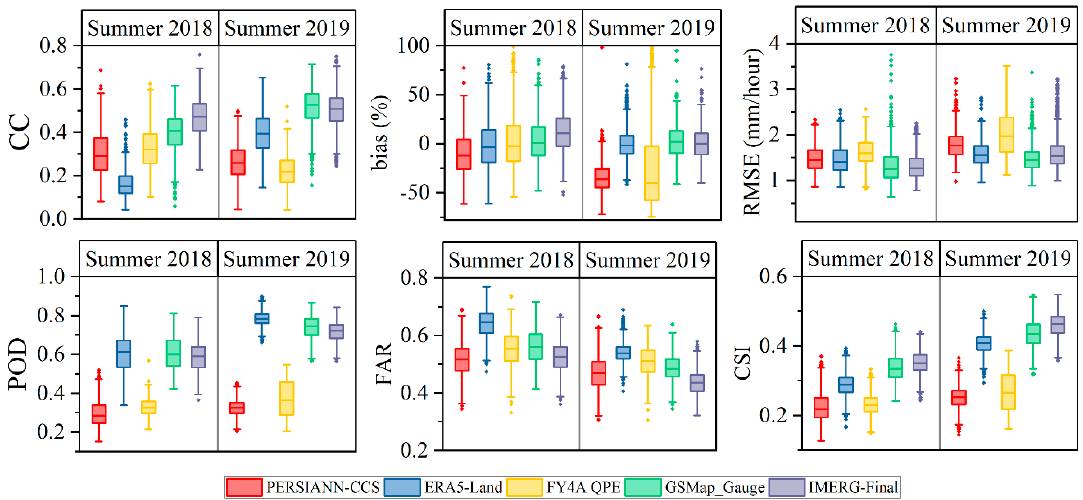
Figure 7. Boxplots demonstrate the relative performances of CC, bias, RMSE, POD, FAR, and CSI of the five precipitation products in summer, from June to August, 2018, and 2019, respectively.